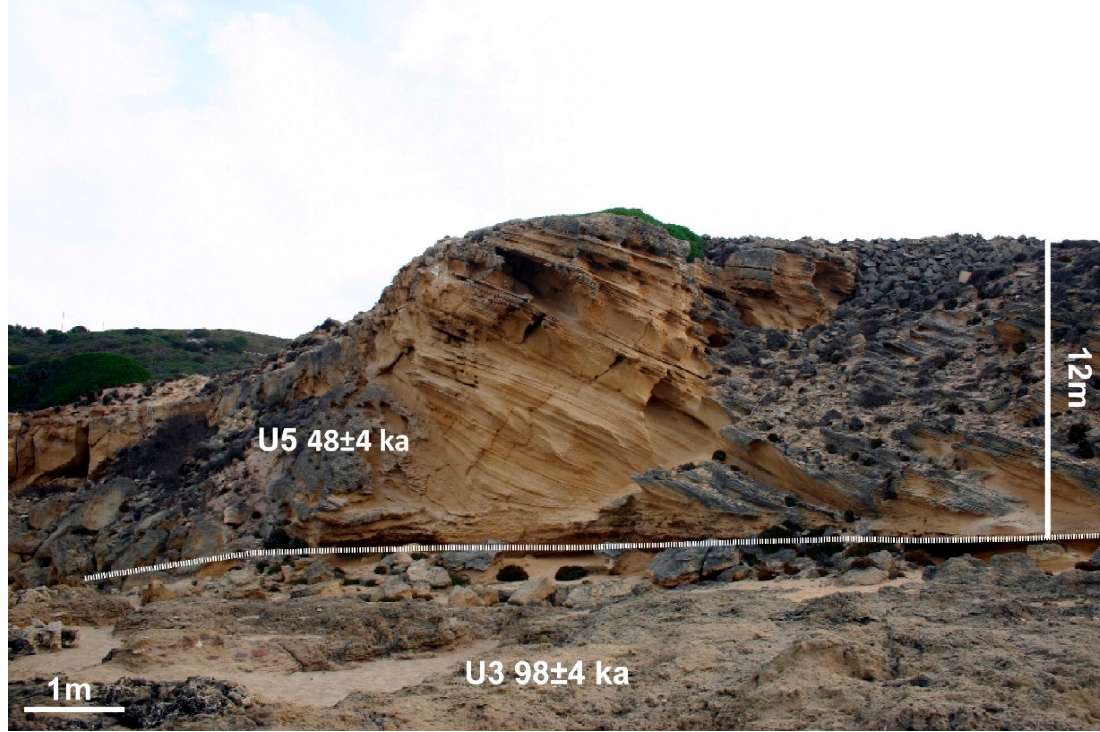
Figure 10. Burantino area. Planar cross-bedded pale yellowish well stratified medium to coarse-grained sandstones of Unit 5. Luminescence ages are made of quartz grains (OSL [34]).